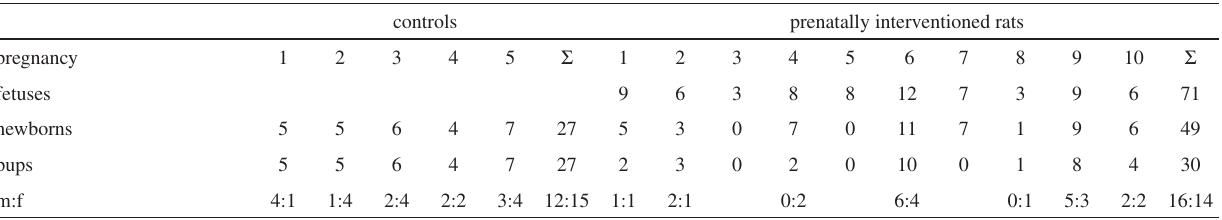
Table 1 - Proportion of male (m) and female (f) newborn rats and pups surviving 1 week after birth for nontreated controls and prenatally-interventioned Fisher rats